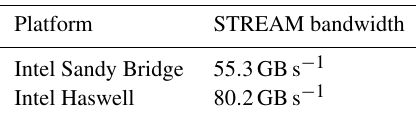
Table 3. Maximum STREAM triad ( a i achieved by varying the number of MPI processes from one to twice the number of physical